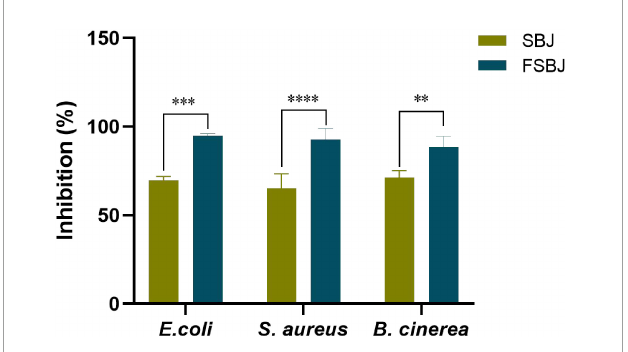
FIGURE5 Antibacterial and antifungal activities of FSBJ and SBJ (** p < 0.01, *** p < 0.001, **** p < 0.0001).